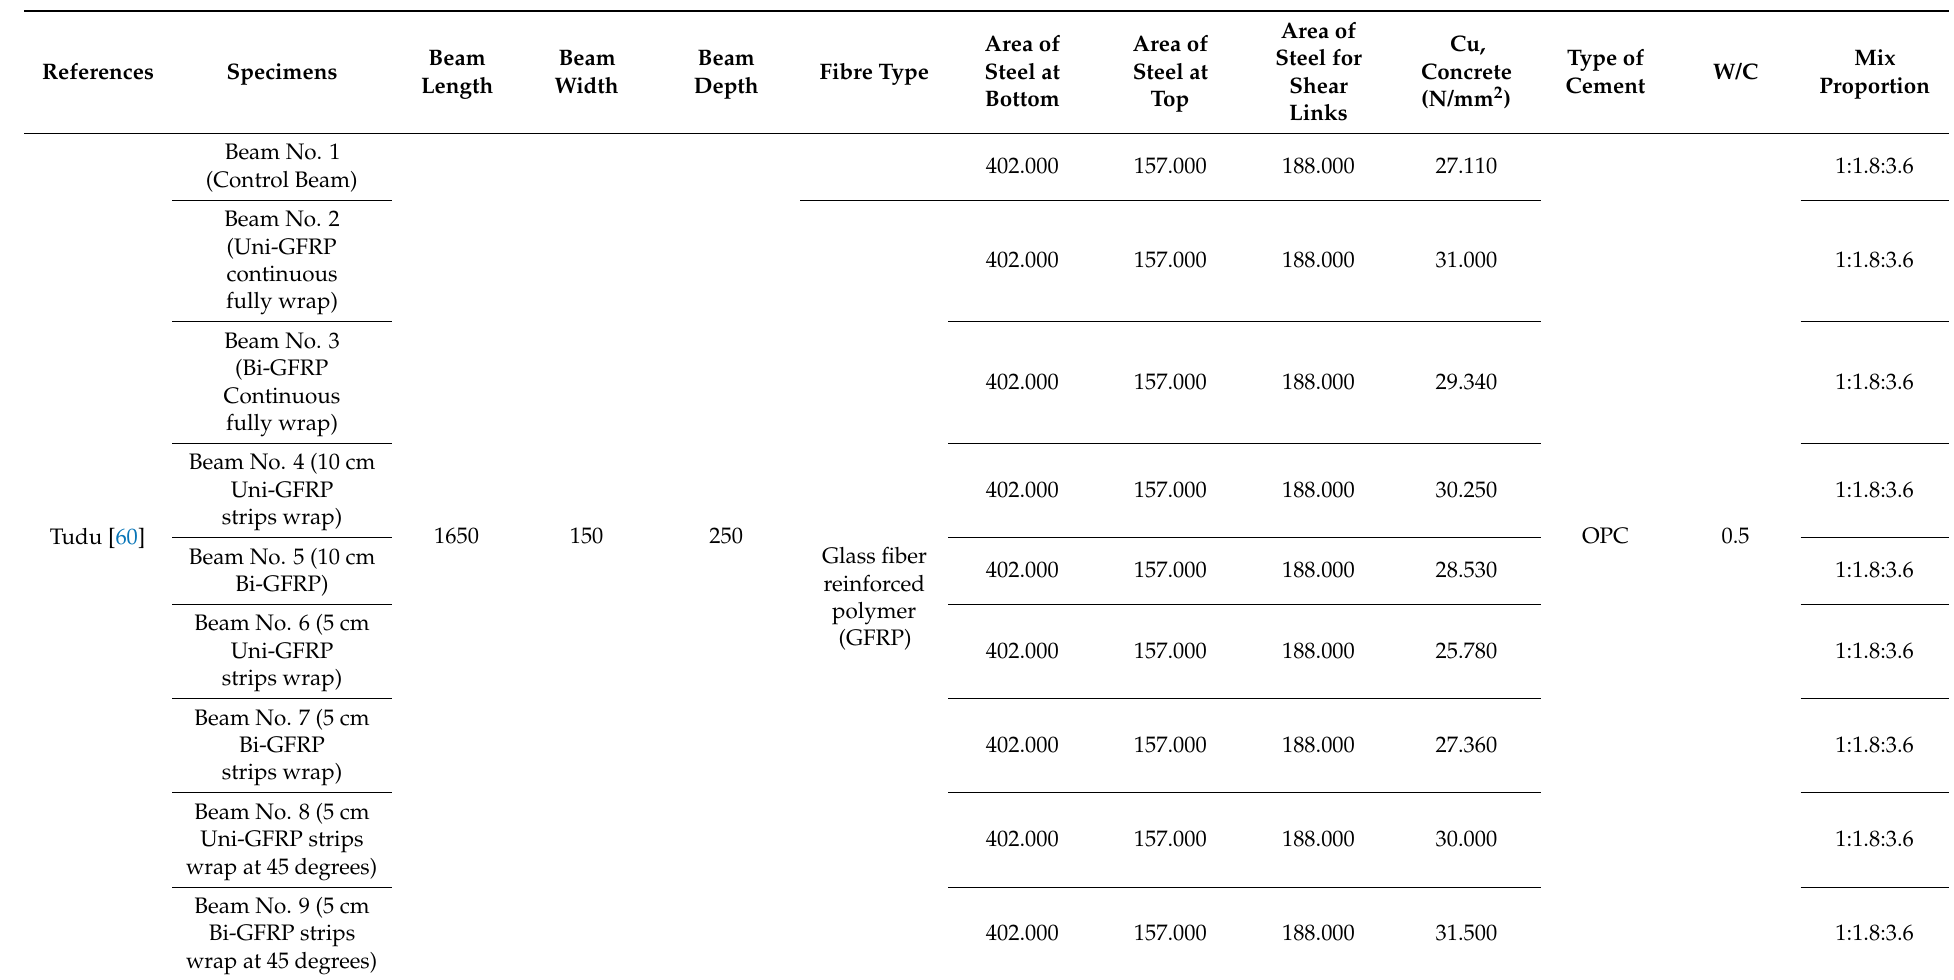
Table 4. Methods of preparation of glass fibre reinforced polymer concrete from previous